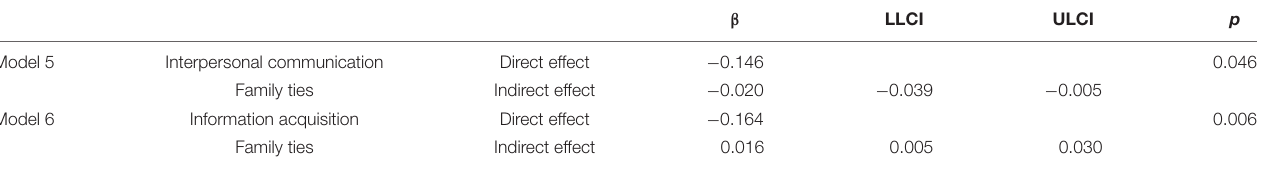
TABLE 6 | Bootstrap test of the mediating